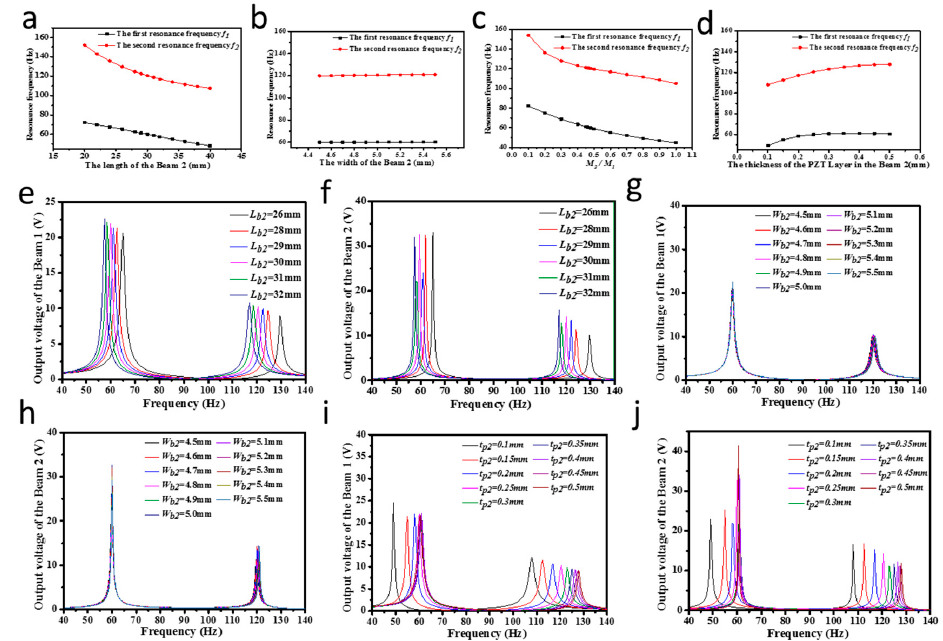
Figure 5. ( a - d ) The dimensions of the Beam_2 vs. resonance frequency; ( e , f ) The length of the Beam_2 vs. the output open-circuit voltage of the Beam_1 and the Beam_2; ( g , h ) The width of the Beam_2 vs. the output open-circuit voltage of the Beam_1 and the Beam_2; ( i , j ) The thickness of the PZT layer in the Beam_2 vs. the output open-circuit voltage of the Beam_1 and the Beam_2.